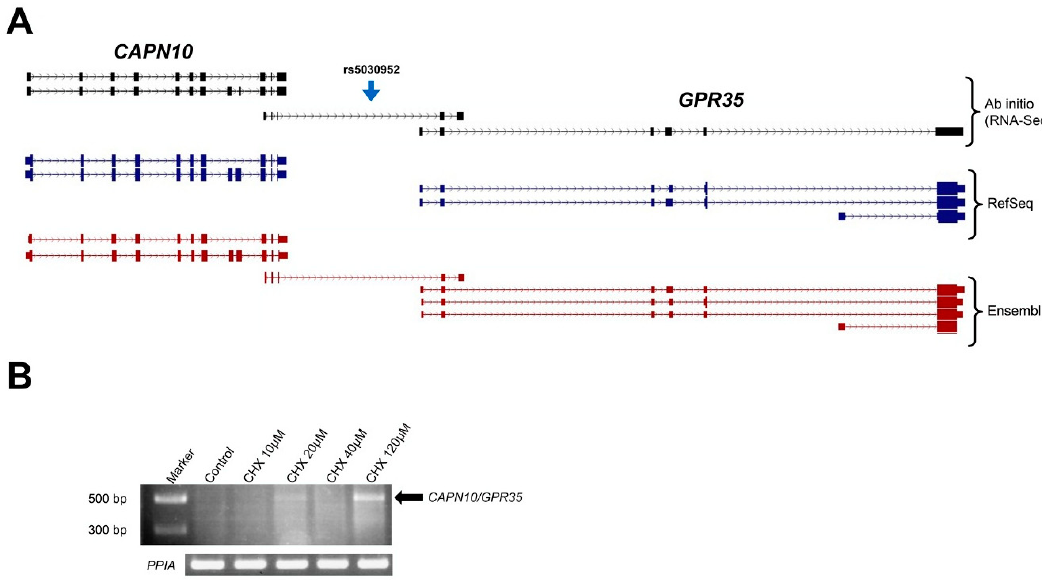
Figure 4. Schematic localization of CAPN10/GPR35 loci . ( A ) Genomic organization of CAPN10 ( left ) and GPR35 ( right ) genes according to RefSeq and Ensembl annotations. The annotation shown in black represents the ab initio transcriptome of HEK293 cells as reconstructed from RNA-Seq data. Boxes indicate the exons. The blue arrow indicates the genomic localization of the polymorphism. A new transcript, automatically annotated in Ensembl database, links the two genes; ( B ) agarose gel electrophoresis picture in HEK293 cell line treated (or not) with cycloheximide (CHX) at growing concentrations as indicated above the gel image. The newly described transcript is indicated by the black arrow. PPIA gene, shown below, was used as a housekeeping control gene.